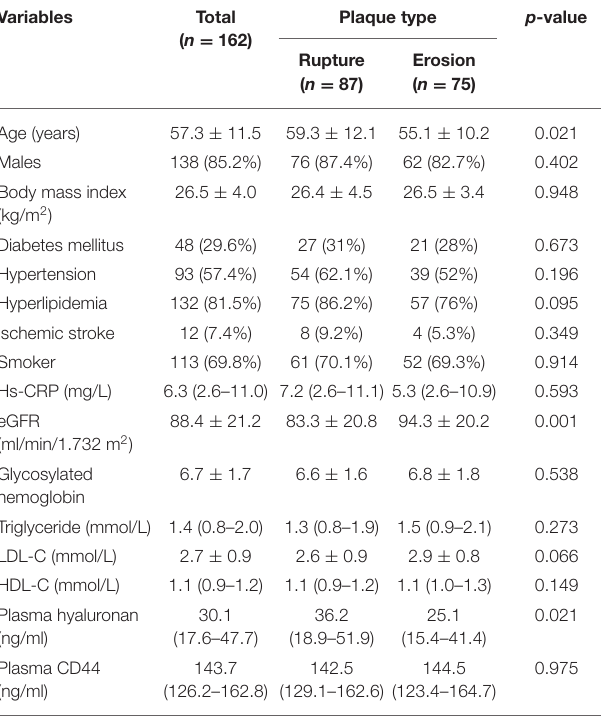
STEMI is significantly lower than healthy controls and patients with S-CAD [143.7 ng/ml (126.2–162.8) vs. 172.1 ng/ml (156.4– 197.4) p < 0.001; 143.7 ng/ml (126.2–162.8) vs. 178.7 ng/ml (160.1–191.3) p < 0.001, respectively] ( Figure 5 ). However, subgroup analysis showed that plasma CD44 levels are not significantly different between patients with PR and those with PE [142.5 ng/ml (129.1–162.6) vs. 144.5 ng/ml (123.4– 164.7), p = 0.975] ( Table 1